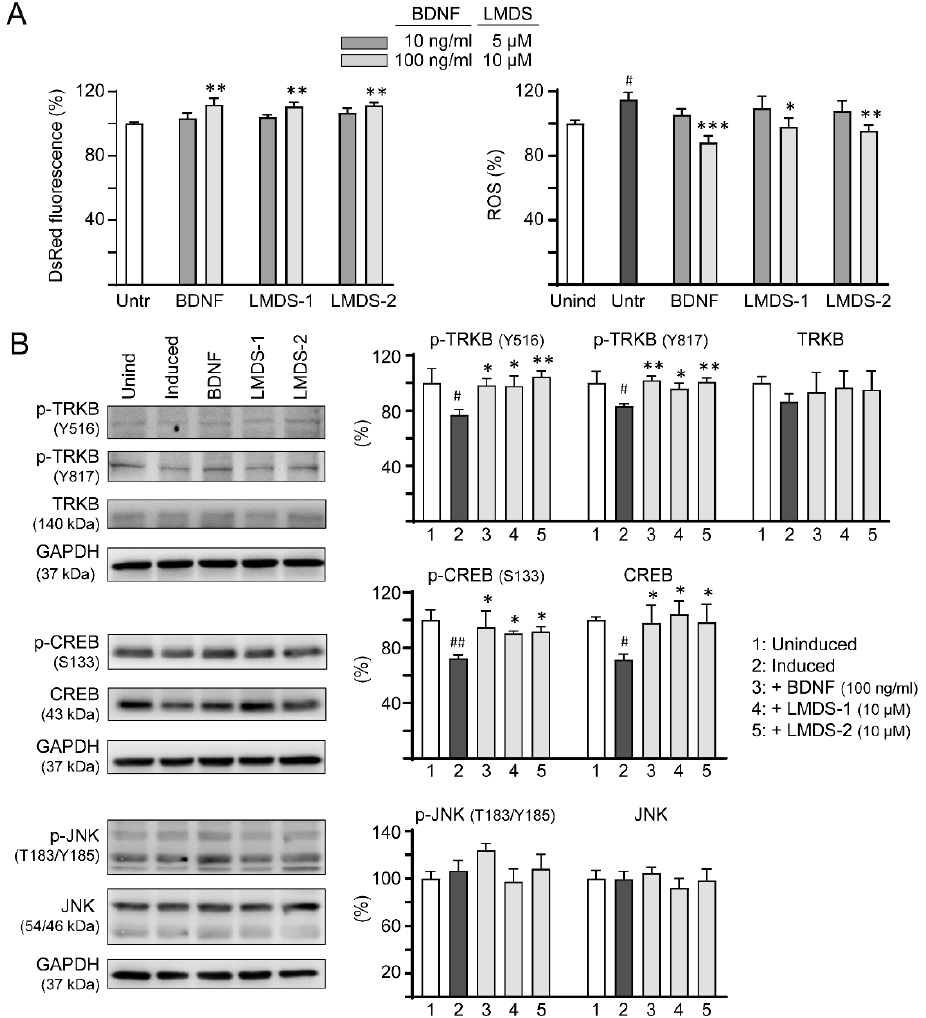
Figure 6. Comparison of BDNF’s and LMDS compound’s signaling activation. ( A ) Assessment of DsRed fluorescence and ROS in ∆ K280 tau RD -DsRed cells uninduced, untreated, treated with BDNF at 10 – 100 ng/mL, or LMDS-1, -2 at 5 – 10 µM ( n = 3). The relative DsRed fluorescence of untreated cells (Untr) or ROS of uninduced cells (Unind) were normalized (100%). ( B ) Assessment of p-TRKB (Y516/Y817), TRKB, p-CREB (S133), CREB, p-JNK (T183/Y185) and JNK levels with BDNF (100 ng/mL) or LMDS-1, -2 (10 µM) treatment by immunoblot using GAPDH as a loading control ( n = 3). To normalize, protein expression level in untreated cells was set at 100%. p values: comparisons between induced vs. uninduced cells ( # : p < 0.05, ## : p < 0.01), or compound-treated vs. untreated cells (*: p < 0.05, **: p < 0.01, ***: p < 0.001) (one-way ANOVA with a post hoc Tukey test).